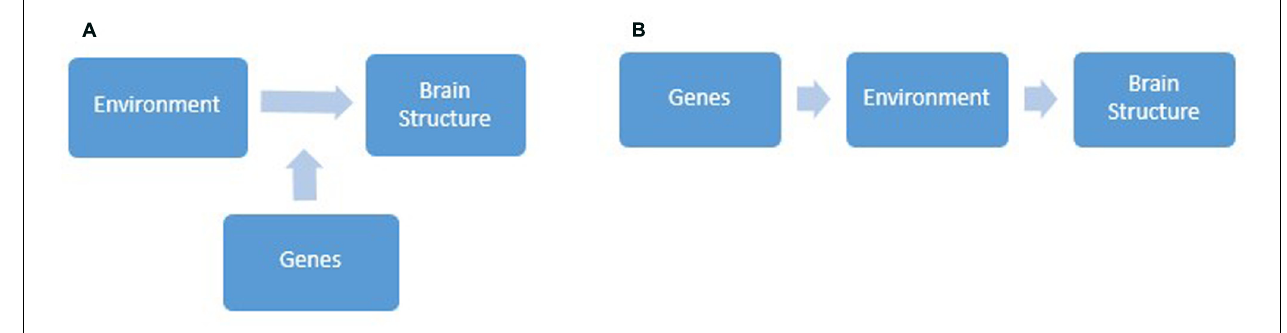
FIGURE 1 | Diagrams depicting gene-environment interaction (A), whereby genes modulate individual differences in sensitivity to environmental influences and in turn brain structure, and